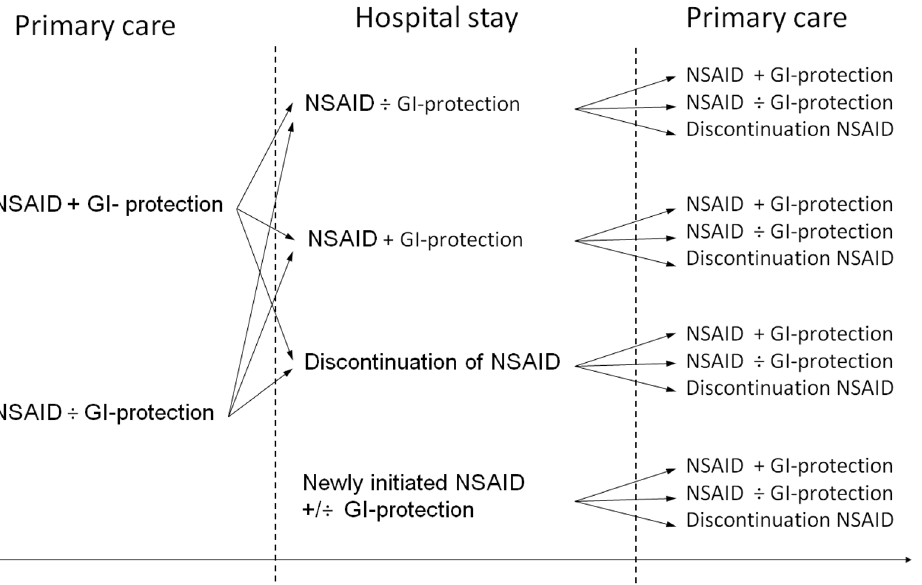
Figure 1. The longitudinal flow for patients treated with NSAID and the use of GI protection (PPI, misoprostol or H2RA).